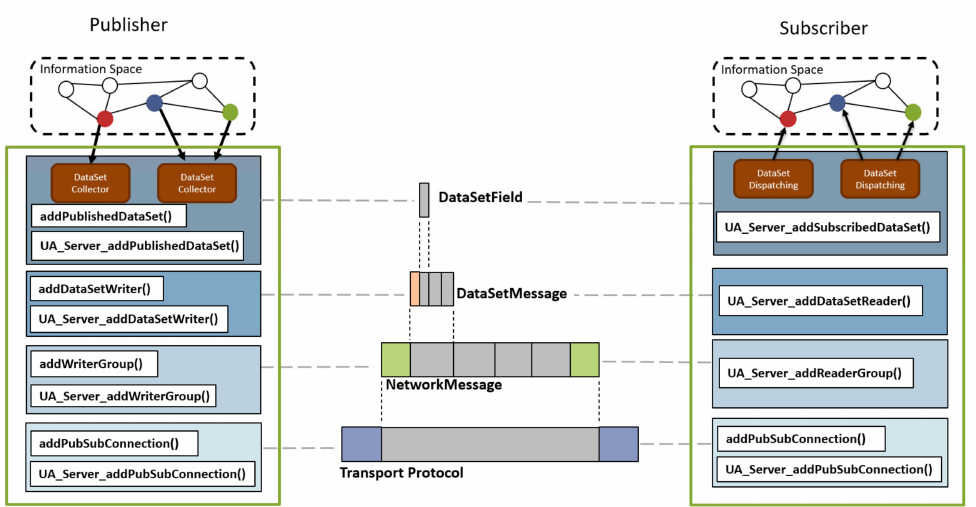
Figure 8. A-Open62541 PubSub protocol stack and